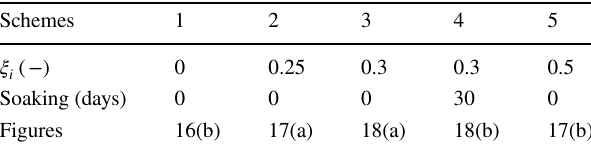
Table 6 Different hydraulic fracturing schemes for the infill well